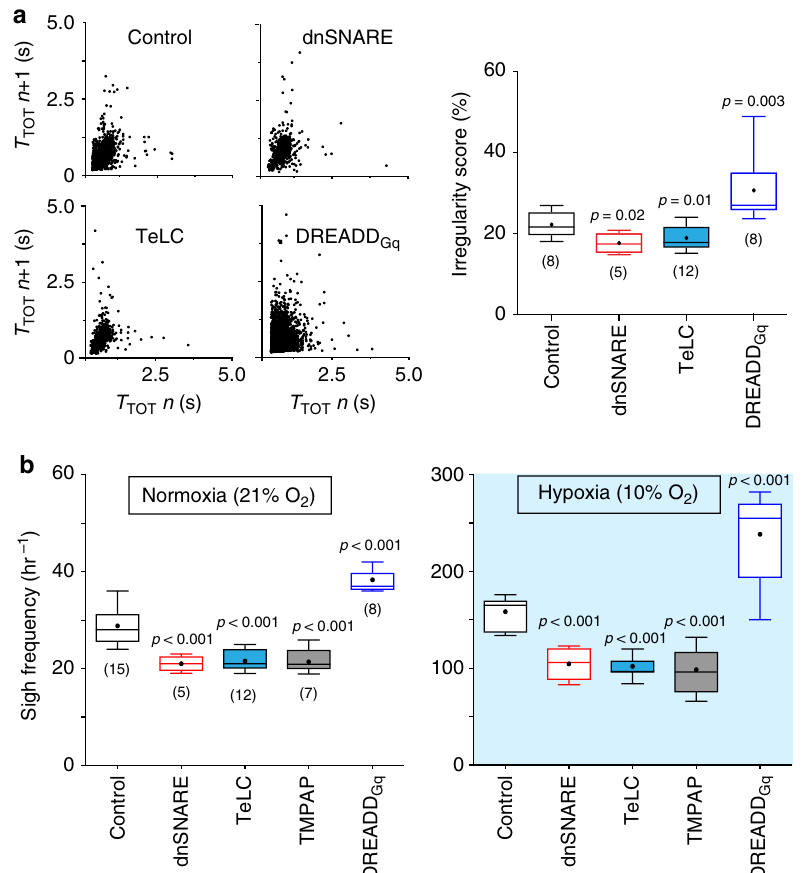
Fig. 3 PreBötC astrocytes modulate the variability of the respiratory rhythm and the generation of sighs. a Regularity of the respiratory rhythm in conditions of activation or blockade of vesicular release mechanisms in preBötC astrocytes. Poincaré plots of the respiratory cycle duration ( T TOT ) for the n th cycle vs. T n th + 1 cycle in rats transduced to express the control transgene (CatCh), dnSNARE, TeLC, or DREADD TOT for the summary data illustrating irregularity score of the respiratory rhythm in conscious rats transduced to express CatCh, dnSNARE, TeLC, or DREADD Gq . b Summary data illustrating sigh frequency at resting conditions and during systemic hypoxia (10% O 2 in the inspired air) in conscious rats transduced to express control transgenes, dnSNARE, TeLC, TMPAP, or DREADD Gq by preBötC astrocytes. Number of animals in each experimental group is indicated